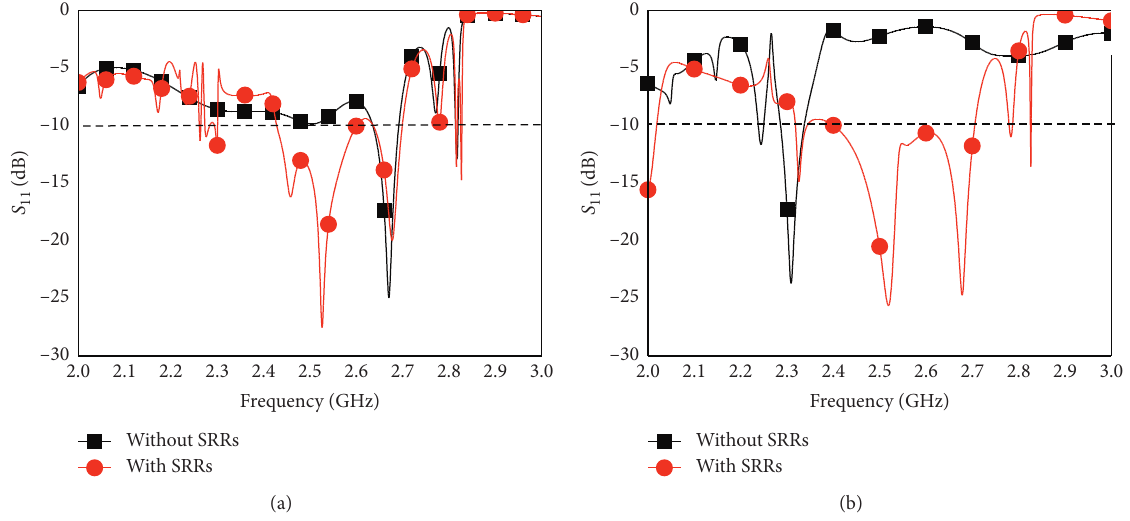
Figure 10: Comparison of the S11 (0.2 λ e ). (a) Inverse balun. (b) Directional balun.